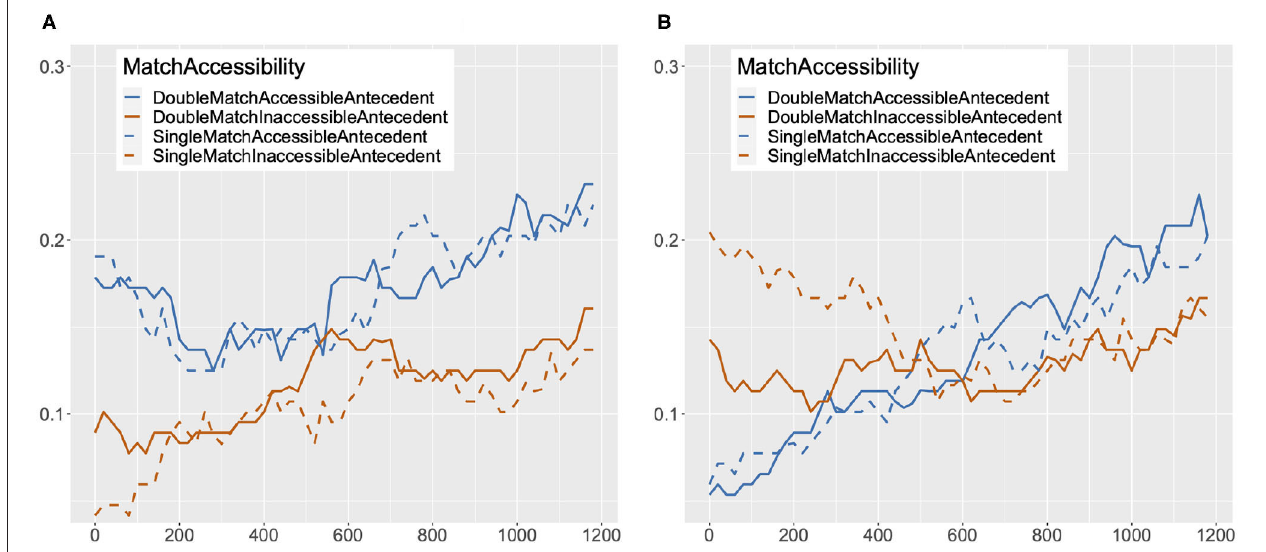
FIGURE 3 | Proportion of looks to accessible/inaccessible antecedent image in single/double match condition at every 20 ms from the onset of the target anaphor to 1,200 ms after the onset, Experiment 2. (A) Proportion of Looks: Reflexive. (B) Proportion of Looks: Pronoun.